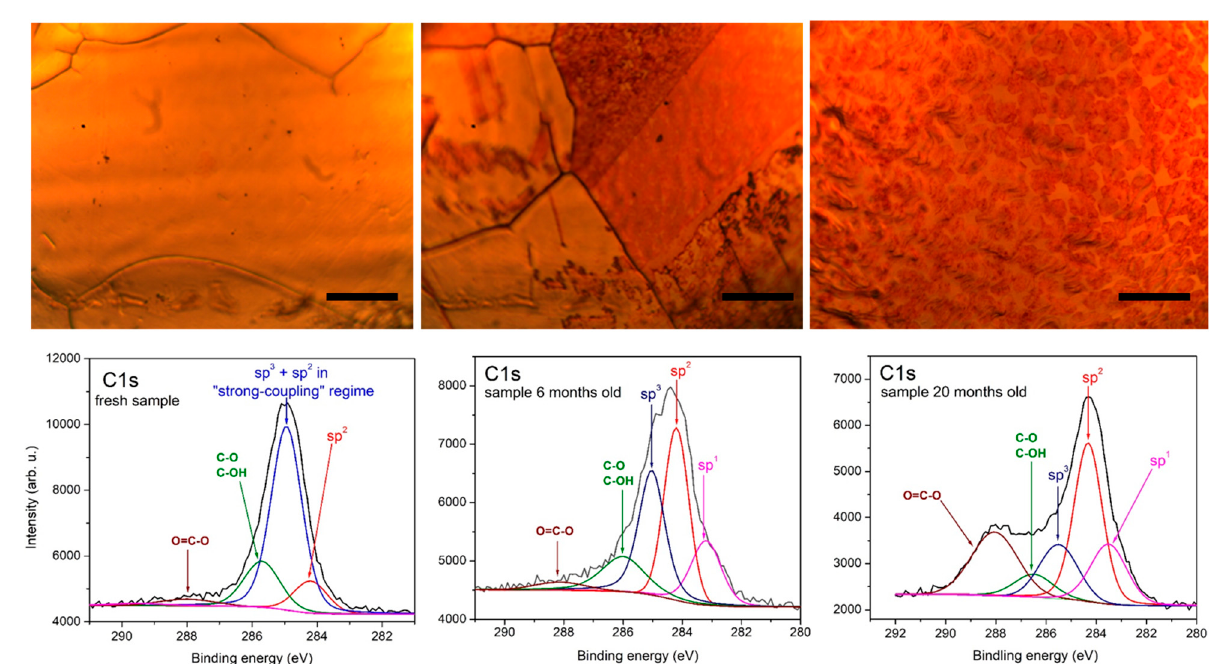
Figure 2. Microscopic images (top) of the three graphene-coated Cu foil samples (left—“fresh”; middle—”6 months”; right—“20 months”) with corresponding XPS spectra of the C1s region (bottom). The scale bars represent 50 μ m. The C1s spectra are fitted according to the expected C-bond types. The fitting components are centered as follows: peak at 284.2 eV—red; peak at 284.9 eV—blue; peak at 285—285.5 eV—dark blue; peak around 286 eV—green; peak around 288 eV—brown, and peak around 283.5 eV—magenta.